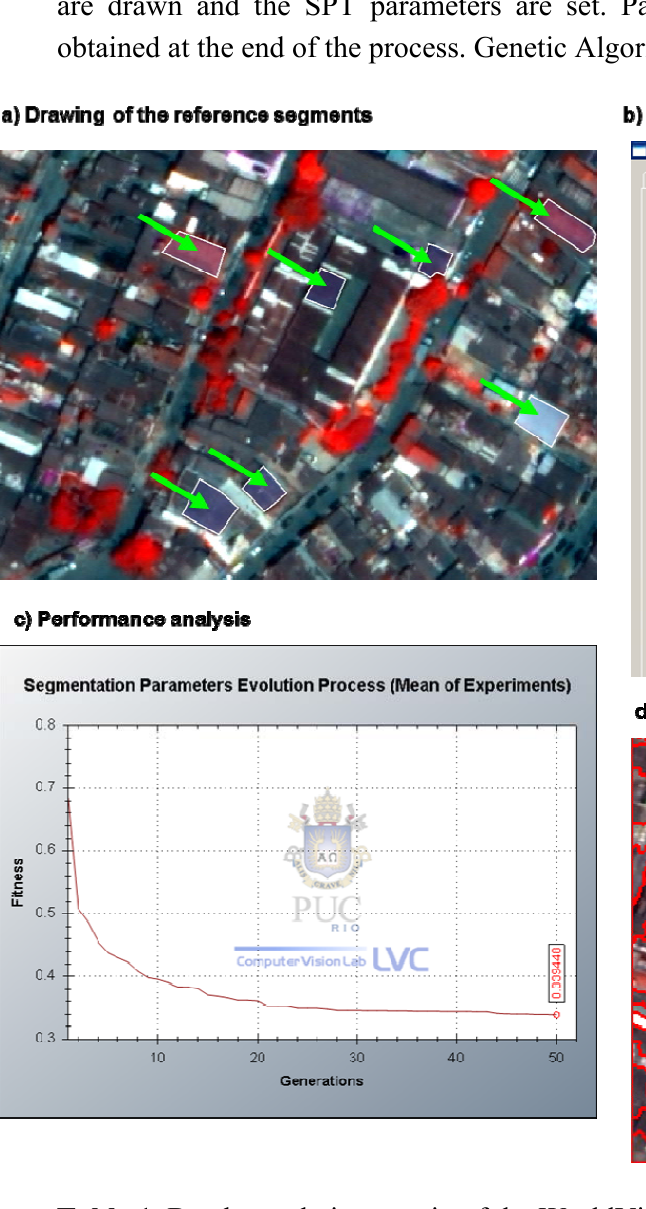
Table 1. Band correlation matrix of the WorldView-2 (WV-2) image of São Paulo (Brazil).